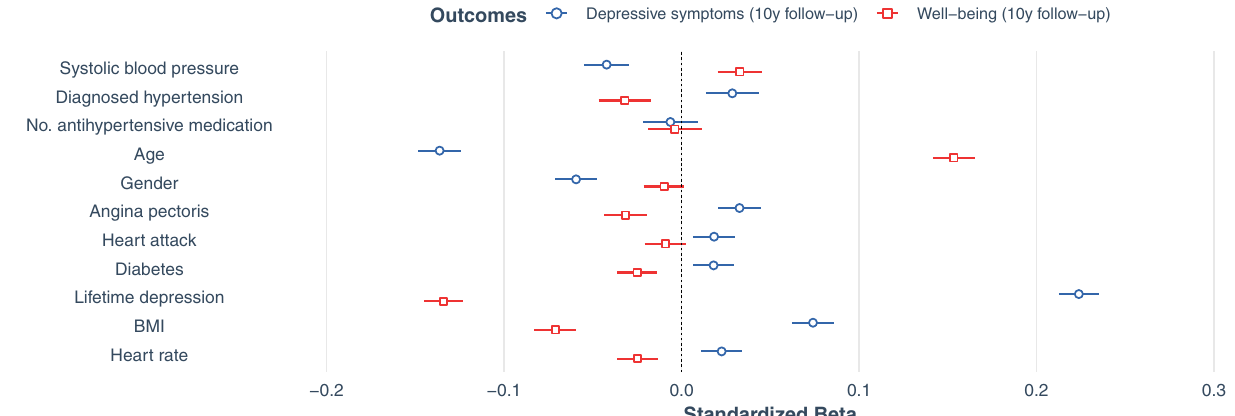
Fig. 3 | Longitudinal associations with mental health outcomes at follow-up assessment. Forest plot shows standardized beta estimates and 95% con fi dence intervals for predictors of interest at baseline (systolic blood pressure, diagnosed hypertension(HTN),and numberofantihypertensives)aswellas covariates.There